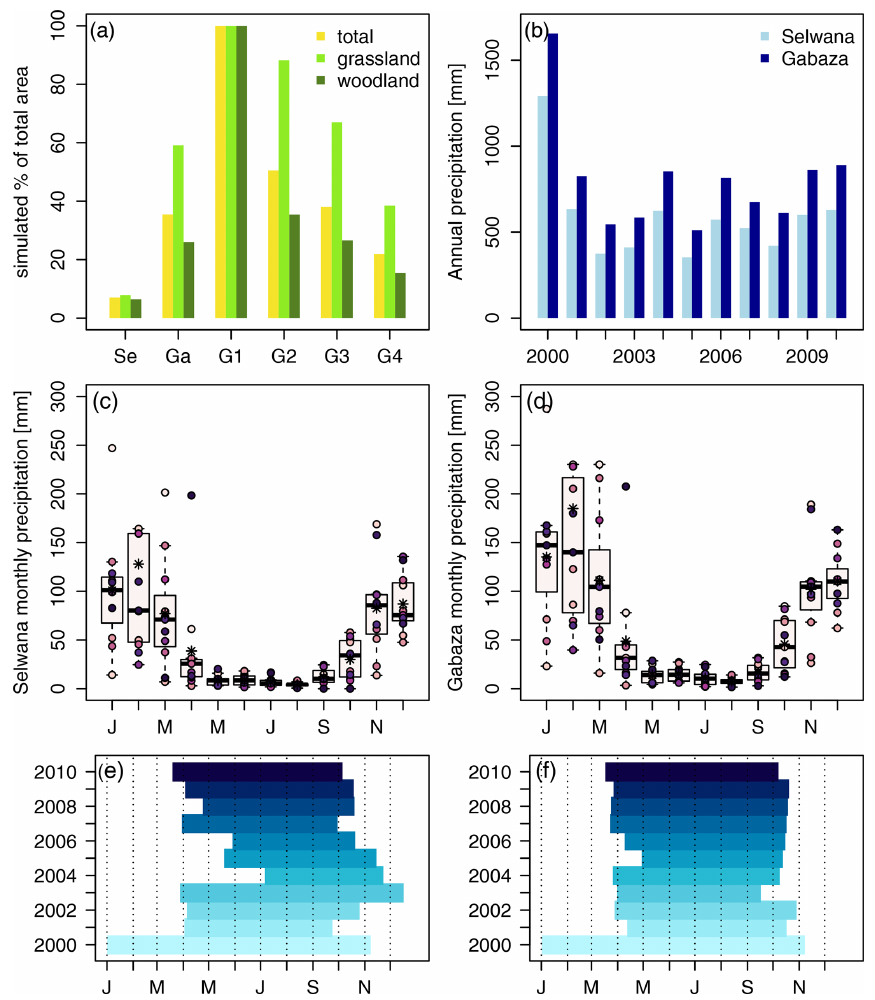
Figure 1. Panel (a) shows the simulated area percentages for the different sites and (sub-)areas, and panel (b) presents the annual precipitation for the years 2000–2010 for Selwana and Gabaza from the AgMERRA climatology used to drive the APSIM and aDGVM2 simulations. Panels (c) and (d) show monthly precipitation at Selwana and Gabaza, respectively; stars indicate the 2000–2010 average, and the dots represent the individual annual values. Panels (e) and (f) show the annual time lines of animal presence on cropland in the RC scenario. A maximum of 150ha (75ha of grassland and 75ha of woodland) was simulated per (sub-)area, amounting to the shown simulated percentages of total area. The abbreviations used in the figure are as follows: SE – Selwana and Ga – Gabaza. G1–G4 indicate sub-areas for Gabaza. For sub-area G1 (total size of 57ha), we simulated all individual hectares of the